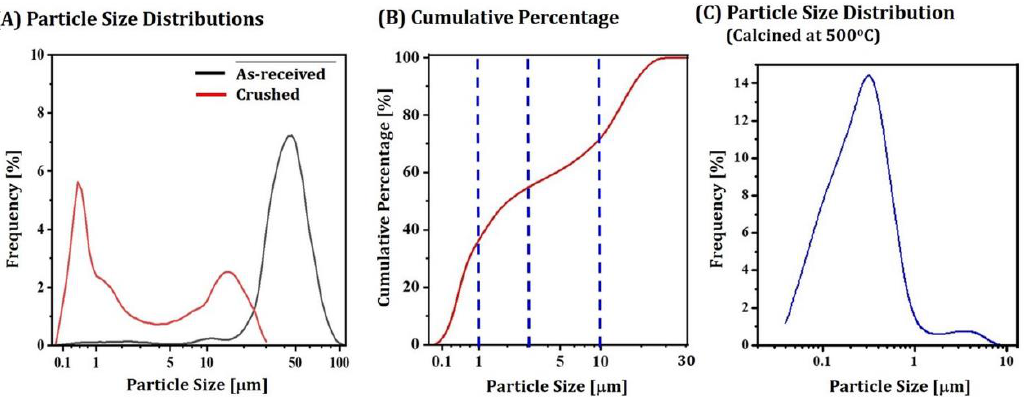
Figure 5. ( A ) Size distributions of as-received 5Y-PSZ granules and crushed 5Y-PSZ particles obtained after ball-milling of granules calcined at 1000 ◦ C ( B ) cumulative particle size distribution of percentage of crushed 5Y-PSZ particles obtained after ball-milling of granules calcined at 1000 ◦ C, and ( C ) size distributions of crushed particles obtained after ball-milling of granules calcined at 500 ◦ C. The dotted lines in Figure 5B represent particle sizes of 1 µ m, 3 µ m, and 10 µ